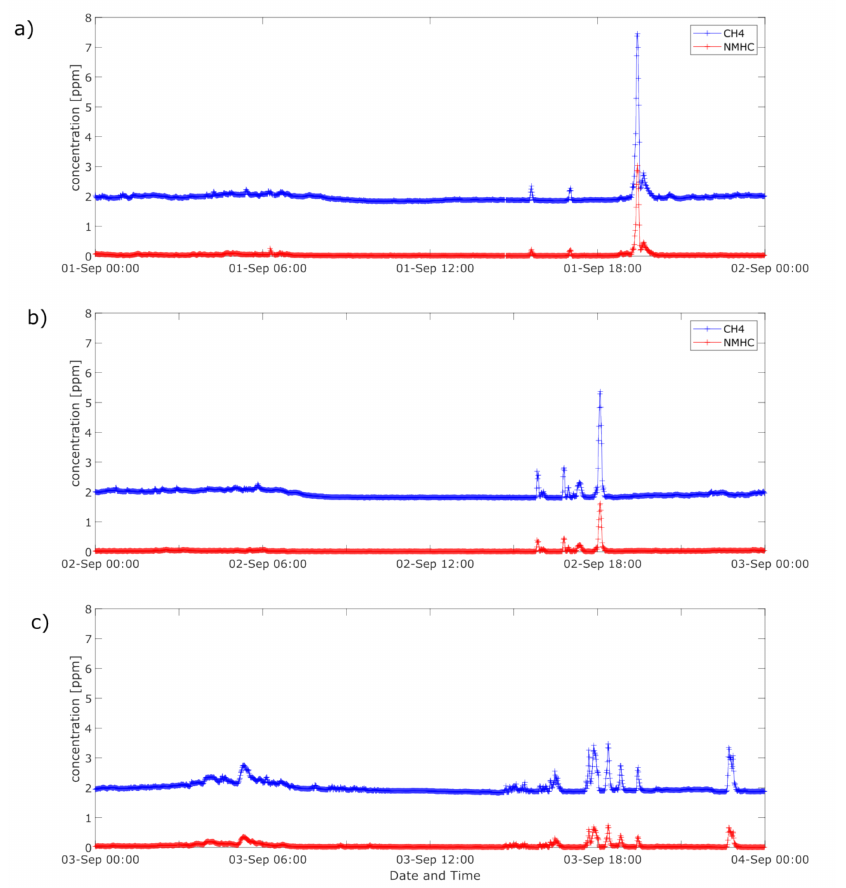
Figure 4. Concentration of CH 4 and NMHC over 1st ( a ), 2nd ( b ) and 3rd ( c ) September 2016, measured at the Stary Wiec